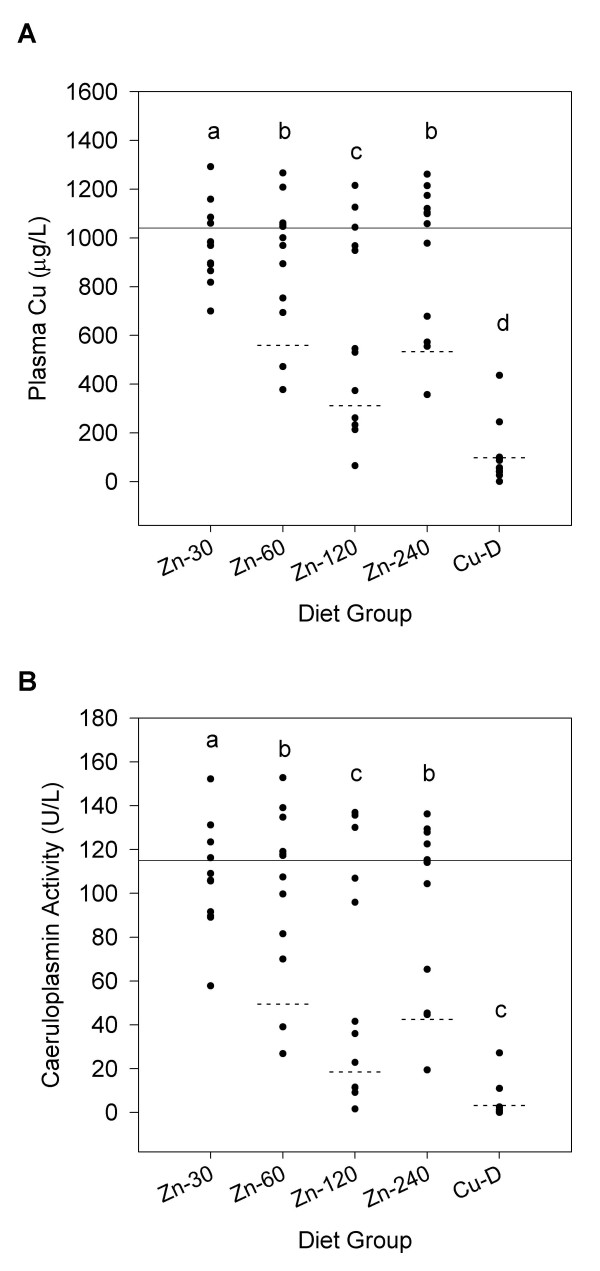
Scatter plots of (A) plasma Cu concentration and (B) Cp activity of rats fed diets differing in Zn and Cu. Each solid circle corresponds to one rat (n = 12/diet group). The horizontal line across all diet groups represents the non-response mean of Zn-30 rats and that of the non-responders from other diet groups (see Methods). The dashed line within each diet group signifies the response mean for that diet group. The non-response mean (diet group Zn-30) and the response means (diet groups Zn-60, Zn-120, Zn-240 and Cu-D) were compared. Diet groups without a common letter differ (P < 0.05).